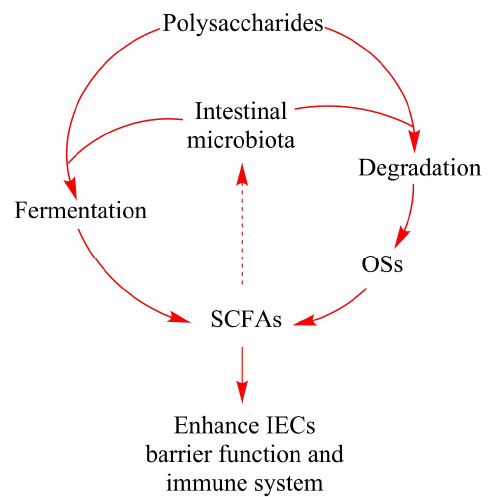
Figure 2. The role of natural polysaccharides in intestinal fermentation. Polysaccharides which cannot be processed by gastric and intestinal enzymes are degraded and fermented by specific intestinal microbiota. Degradation of polysaccharides produces a large number of oligosaccharides that are conducive to host health. Fermentation of polysaccharides and oligosaccharides produces SCFAs and other metabolites. SCFAs can be easily absorbed and promote the IECs barrier function and immune system. During the intestinal fermentation, polysaccharides, oligosaccharides or the metabolites like SCFAs may promote the growth of certain intestinal bacteria, thus changing the composition of intestinal microbiota and affecting the host health. Abbreviations: OSs, oligosaccharides; SCFAs, short-chain fatty acids; IECs, intestinal epithelial